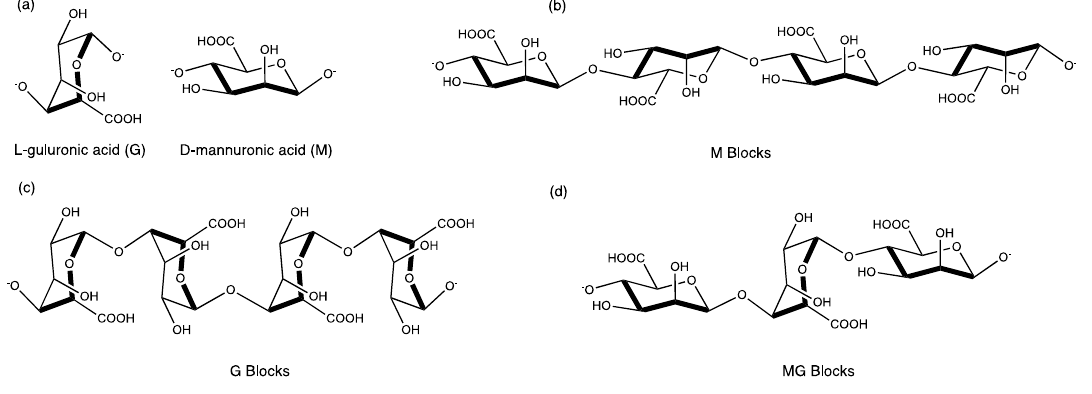
Figure 1. ( a ) Alginate monomers L ‐ guluronic acid (G) and D ‐ mannuronic acid (M) and characteristic polymeric ( b ) M blocks, ( c ) G blocks and ( d ) MG blocks [adapted from [10] ]. Figure created using ChemDraw 15.1.